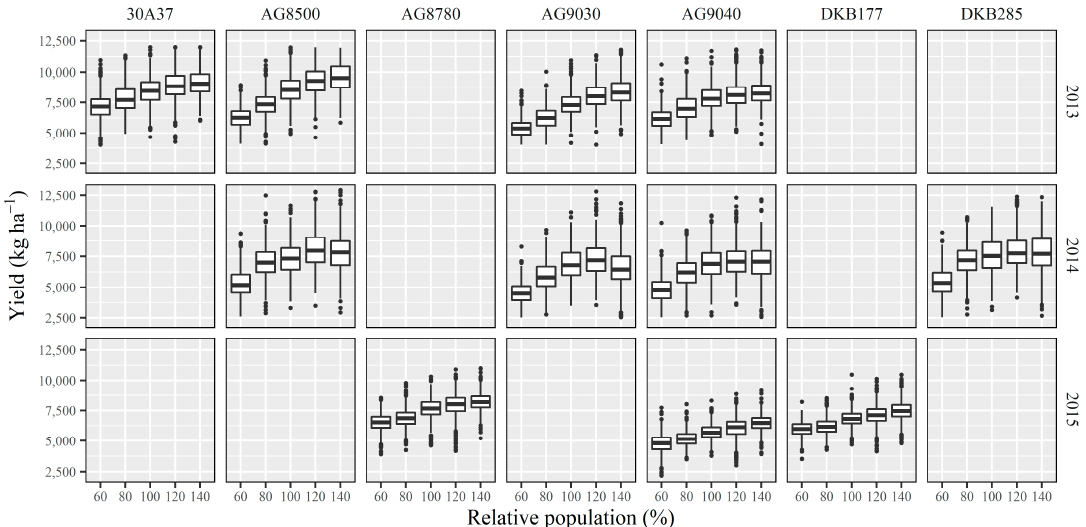
Figure 6. Relationship between yield and relative seeding rate for maize in the experimentation